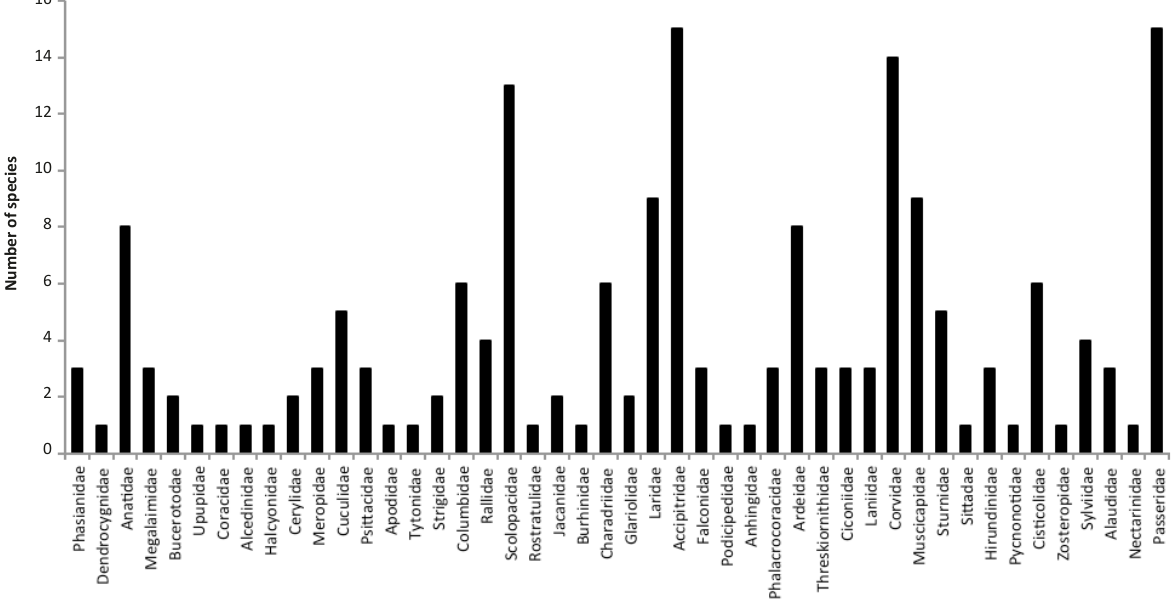
Figure 4. Number of bird species according to families observed in the Yamuna Nagar District.